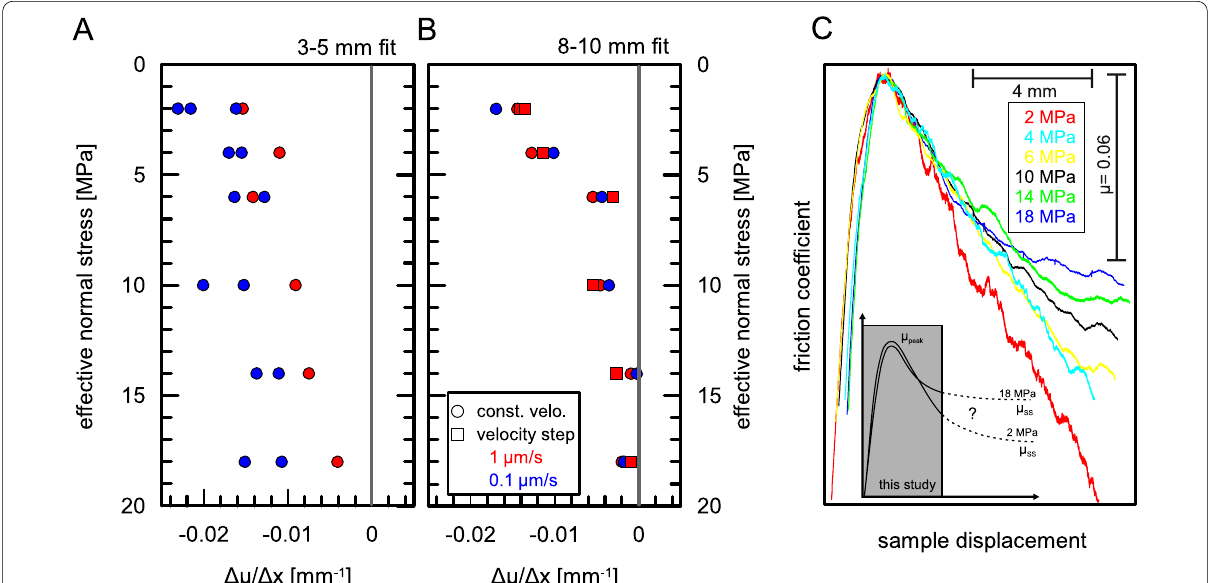
Fig. 4 Experimental results for friction slip dependence. Slip dependence of friction as a function of effective normal stress in both velocity step and constant velocity experiments. Friction slip dependence is shown for A 3–5 mm and B 8–10 mm displacement. C Friction-displacement curves for 0.1 µm/s graphically normalized by peak friction to illustrate slip weakening behavior from peak friction toward “steady-state”. (Inset) Conceptual model of slip weakening behavior under varying effective normal stress. Gray represents data from our direct shear tests with 10 mm maximum